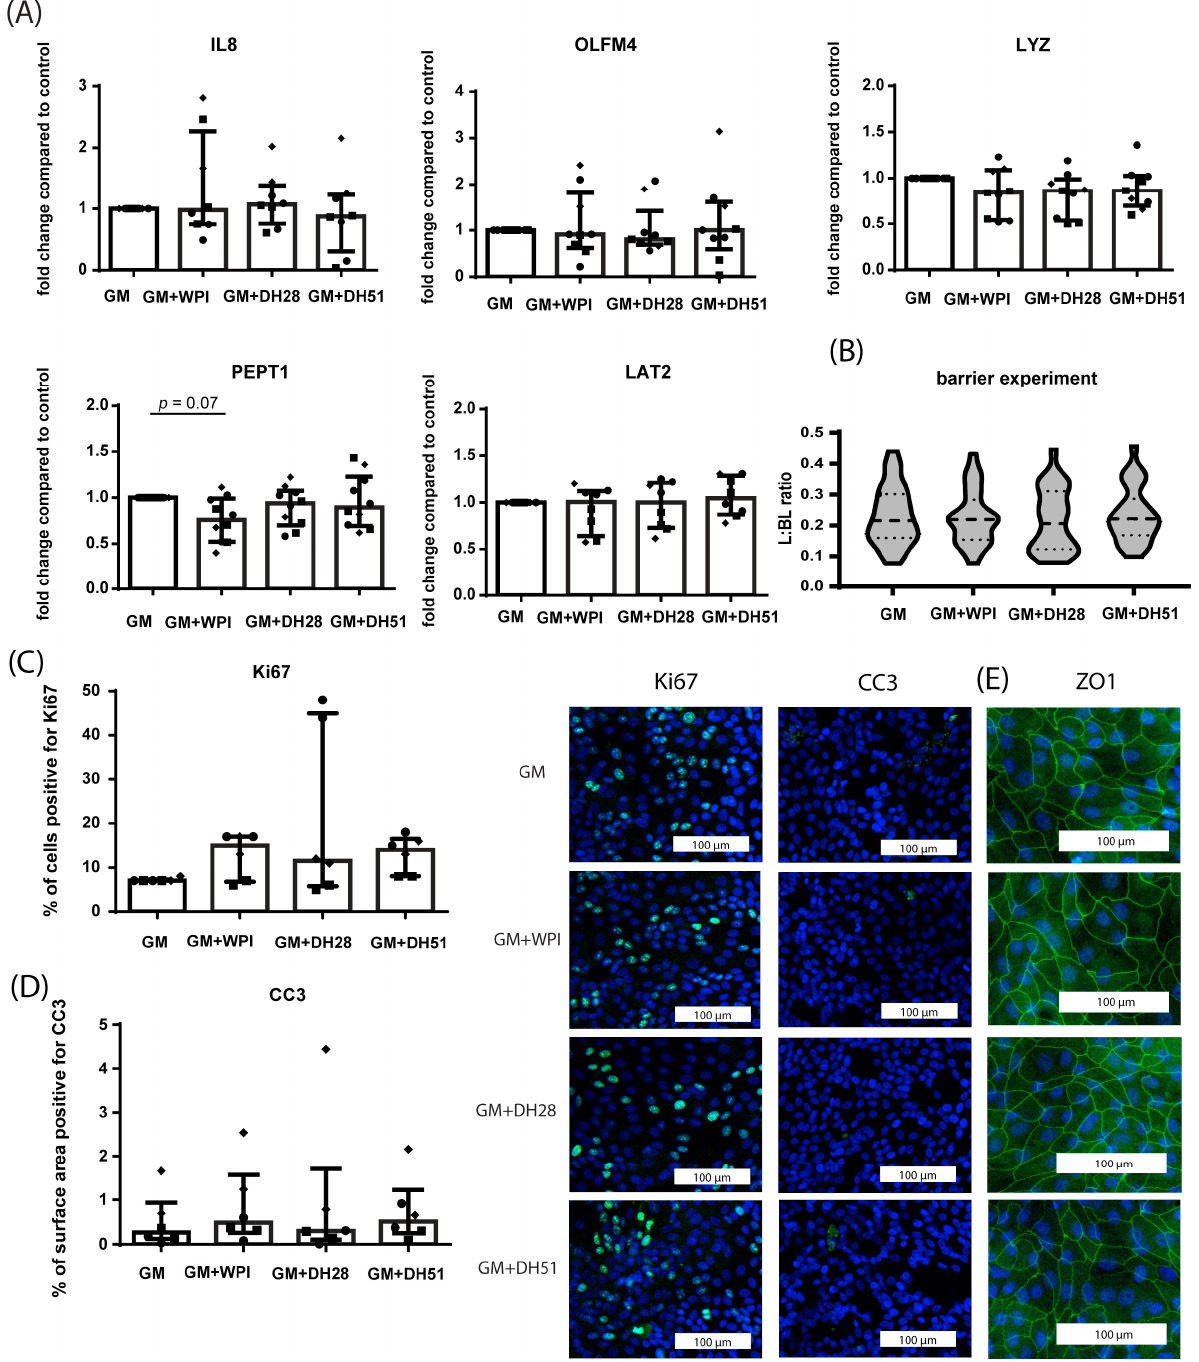
Figure 6. Effect of WPI, DH28, and DH51 on crypt-like HIO (monolayer- and 3D-cultured) in a healthy setting (normoxia). ( A ) mRNA expression of IL8 (pro-inflammatory cytokine), OLFM4 (stem cells), LYZ (Paneth cells), PEPT1 (di/tri-peptide transporter) and LAT2 (amino acid transporter)